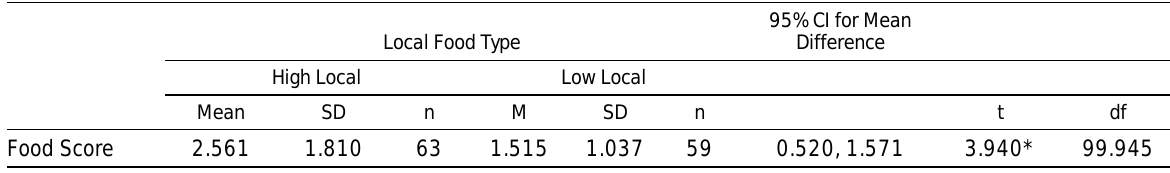
Table 7. Results of t-tests and Descriptive Statistics for Food Score by Local Food